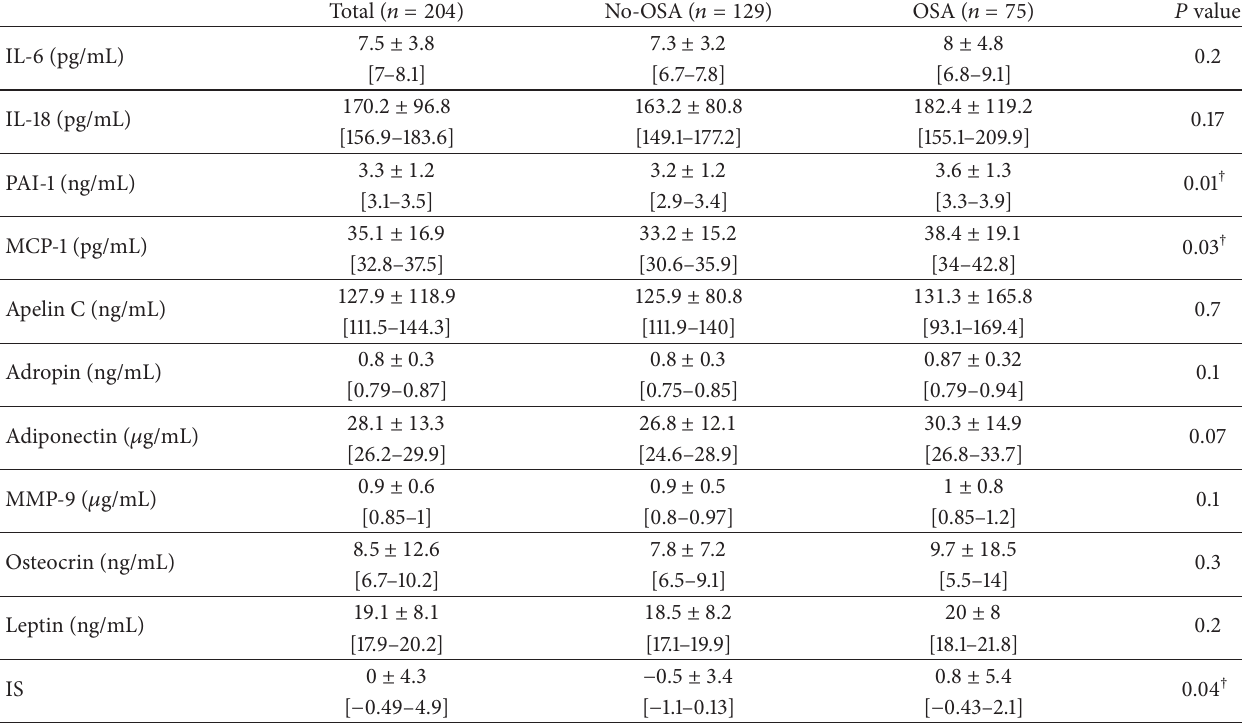
Table 3: Inflammatory markers in OSA and non-OSA obese